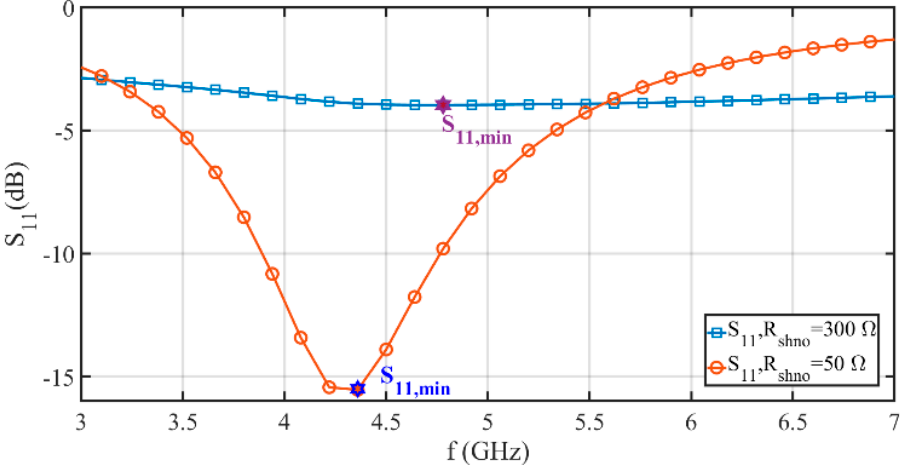
Figure 18. S 11 of the front end (extracted view).